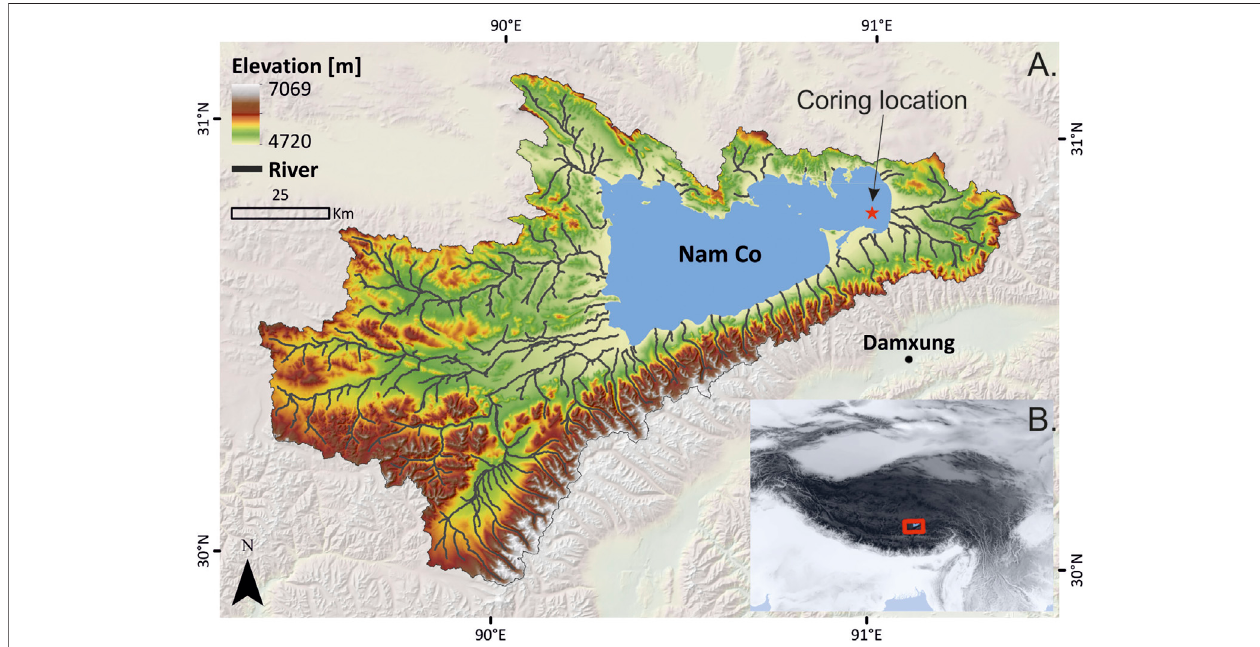
FIGURE 1 | Lake Nam Co and its catchment (A) , with its location on the Tibetan Plateau (B) .